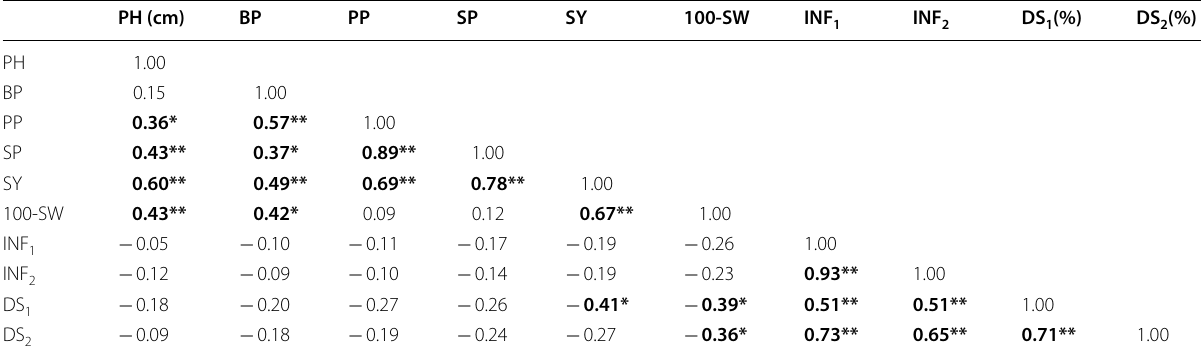
Table 8 Correlation coefficients among studied traits (combined data)